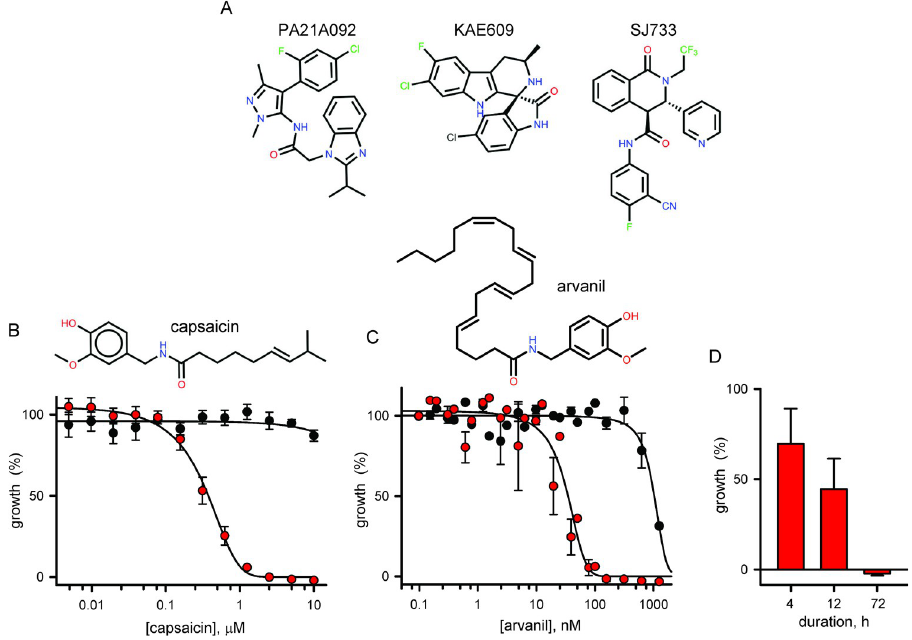
Fig 2. Conditional permeation of the parasite plasma membrane is lethal. (A) Structures of indicated antimalarial lead compounds targeting PfATP4. (B) Structure of capsaicin. Bottom panel shows mean ± S.E.M. parasite growth at indicated [capsaicin] for Dd2- TRP and wild-type Dd2 (red and black symbols, respectively), determined by combining results from 6–7 independent trials each; Dd2- TRP is killed by capsaicin. (C) Structure of arvanil. Plot shows mean ± S. E.M. parasite growth at indicated [arvanil] for Dd2- TRP and wild-type Dd2 (red and black symbols, respectively), determined from 3 independent trials each. (D) Mean ± S.E.M. parasite growth over 72 h with a pulse-chase application of 10 μ M capsaicin for indicated durations, determined from 3–5 independent trails with normalization to 100% growth for DMSO control and 0% for matched cultures treated with 20 μ M chloroquine for 72 h. Reduced growth relative to DMSO control indicates rapid killing with short applications of